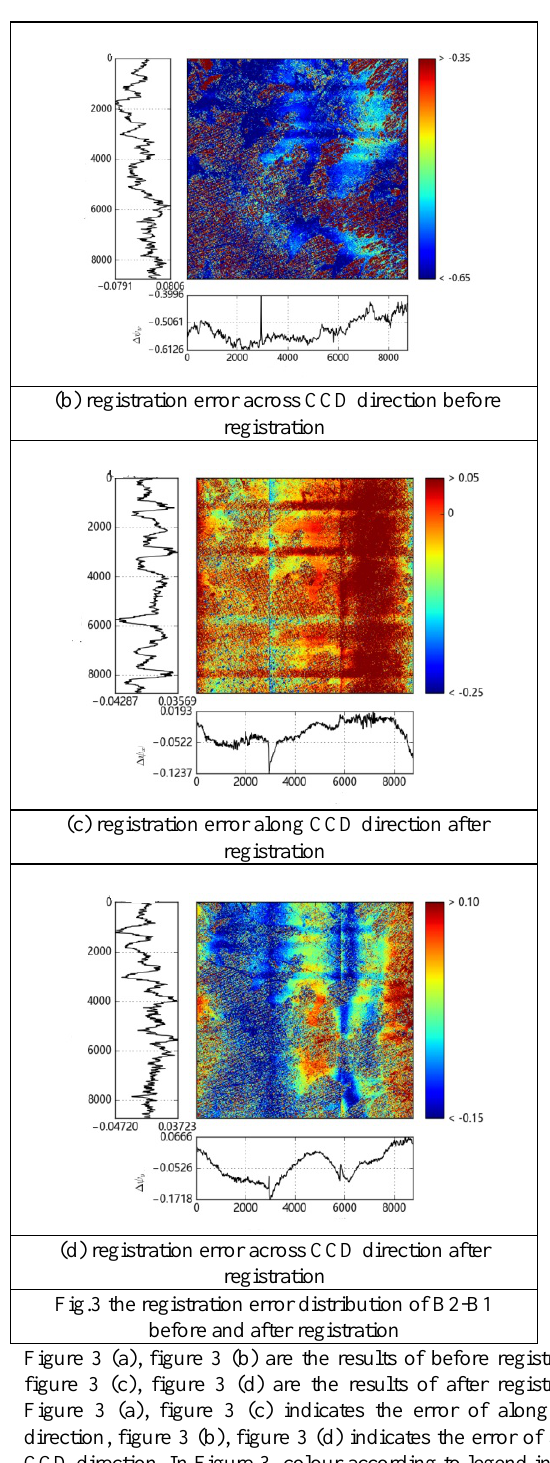
Fig.3 the registration error distribution of B2-B1 before and after